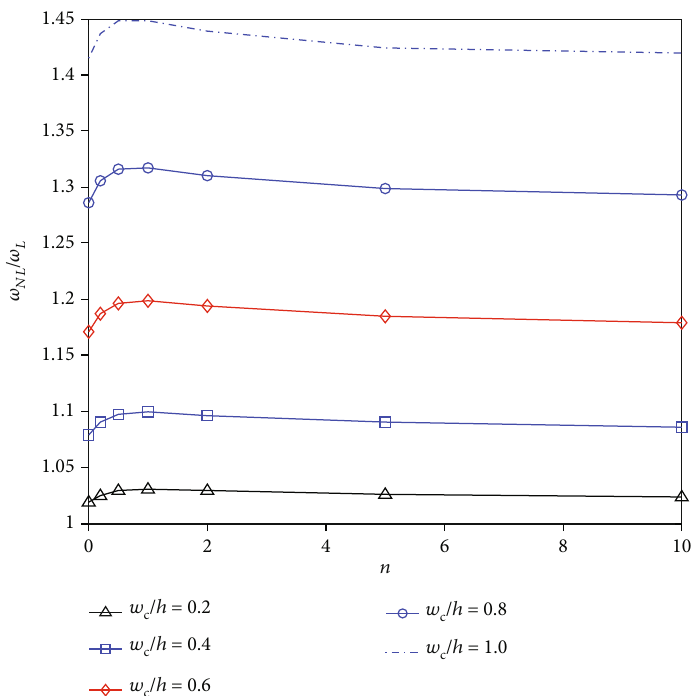
Figure 8: E ff ect of volume fraction index n , q = 0 : 5 , a / h = 10 , SSSS.